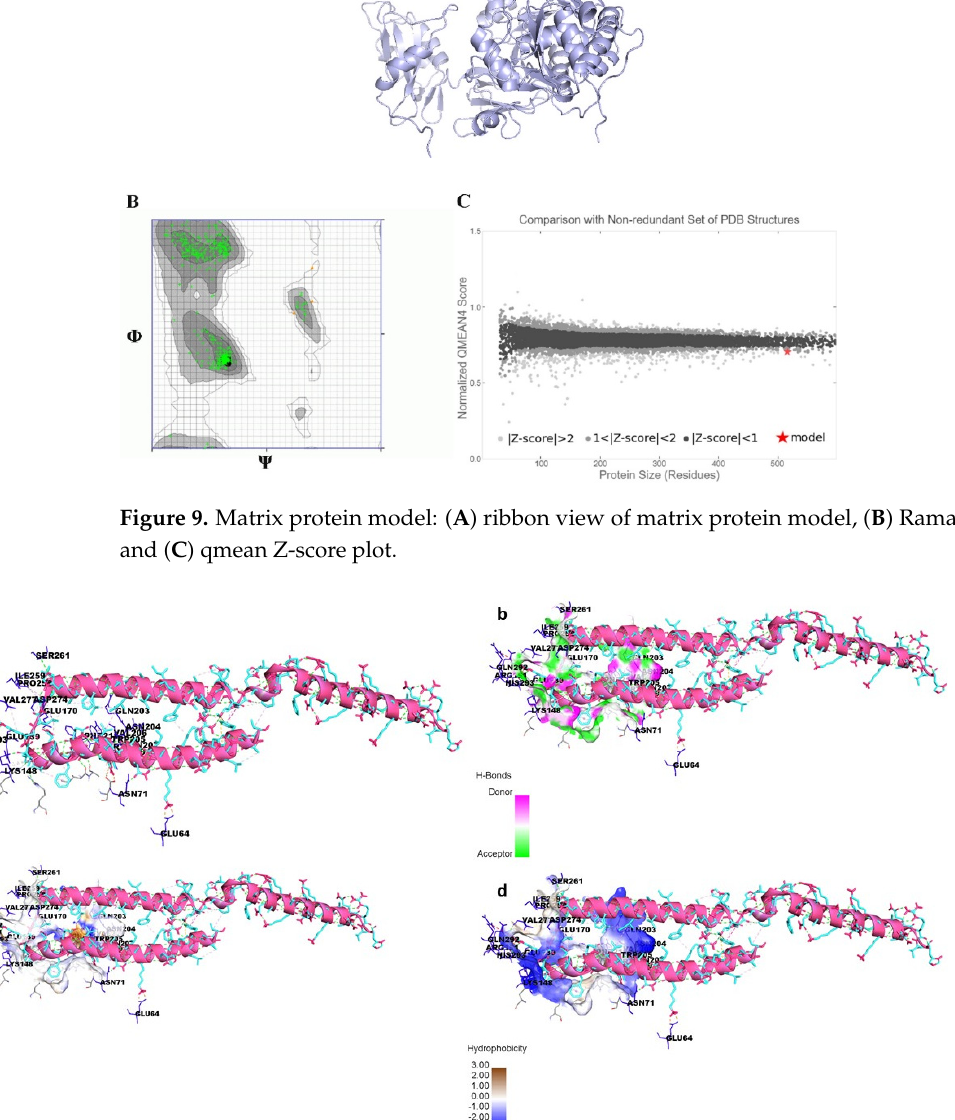
Figure 11. ( a ) Mode of binding of EntP (indigo) peptide with protein stabilized by non-bonding interactions with amino acid residues. ( b ) Hydrogen-bonding interactions of peptide with protein residues. ( c ) Representation of π – π interaction stabilizing the binding of EntP. ( d ) Hydrophobic cavity supporting peptide binding to protein. 4. Discussion Bacteriocins have the potential to be used in a variety of applications because it has been demonstrated that it is possible to create vast quantities of them without the use of pathogens. The versatility of bacteriocins allows for a wide range of applications, and their modular design allows for the creation of custom bacteriocins. The availability of bacteri- ocins broadens the options even more, enabling their usage in the home or workplace to